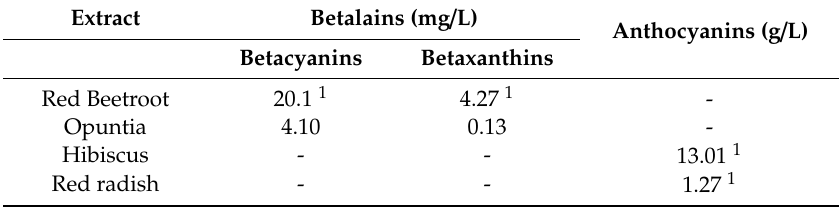
Figure 1. Absorption spectrum of opuntia extract in aqueous solution (at a concentration of 4 mg/mL). Inset: Spectral decomposition in the visible spectral region to obtain betacyanins and betaxanthins concentrations. Table 1. Concentration of pigments in the extracts used determined by UV-Vis absorption.